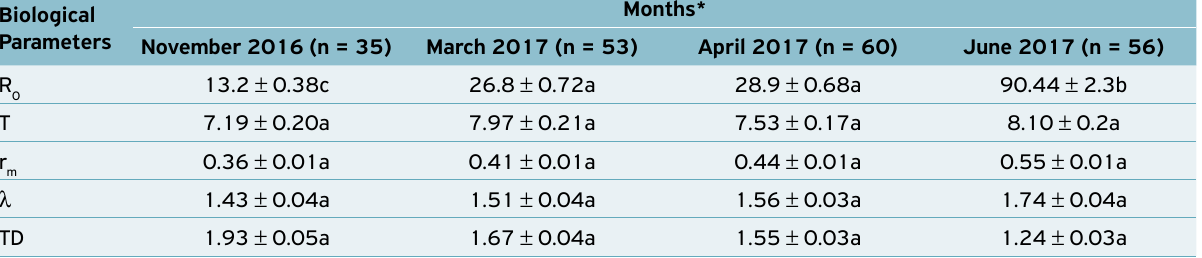
*Mean temperature (°C): November — 30.5; March — 26.1; April and June — 26.5; R inability to increase in number; λ : finite increase rate; TD: time for the population to double. Means with the same letter within a row are not significantly different according to Student’s t test (p <